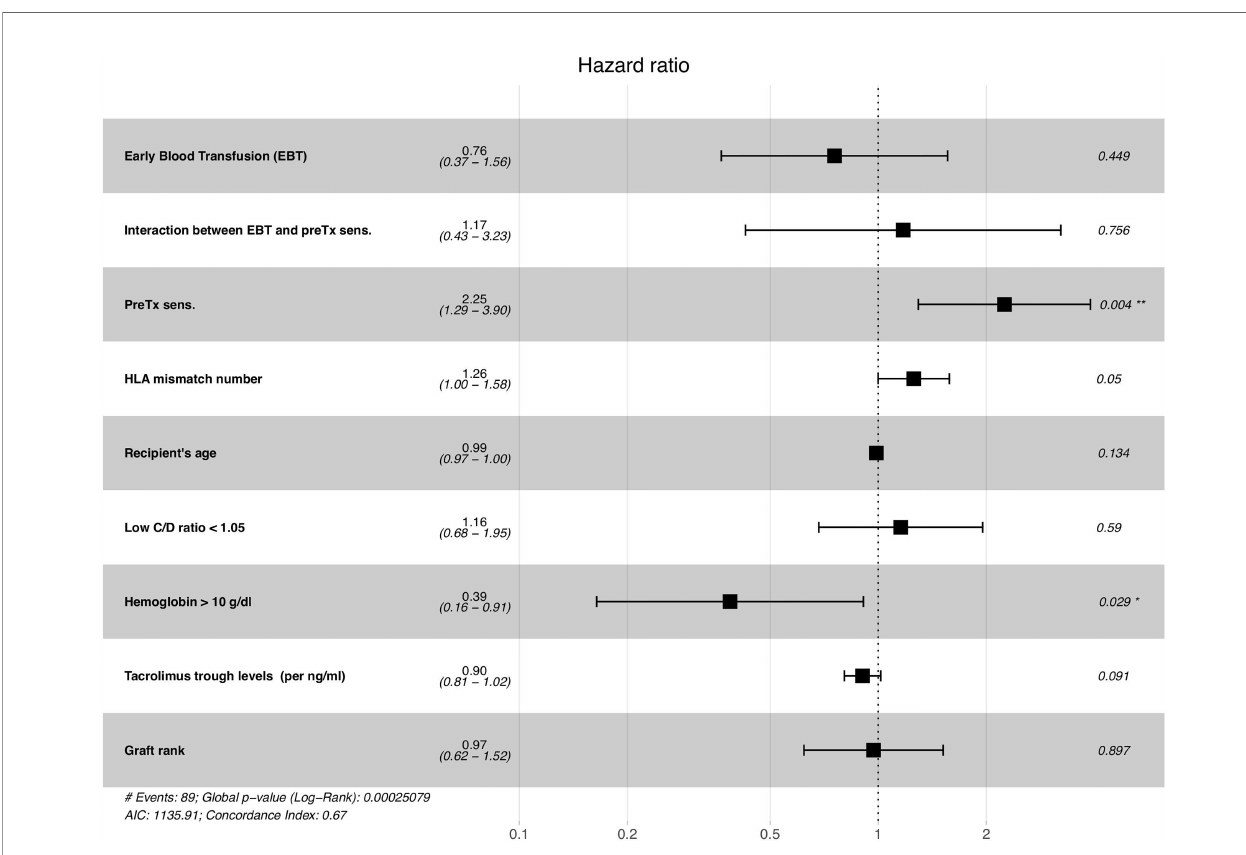
FIGURE 2 | Multivariate Cox ’ s survival model predicting the occurrence of a dnDSA, based on signi fi cant univariate predictors of dnDSAs. PreTx = pre- transplantation; sens. = HLA sensitization (presence of anti-HLA antibody); C/D ratio = Tacrolimus concentration-to-dose ratio. Time-varying covariates were considered as such in this multivariate Cox model *p < 0.05, **p <